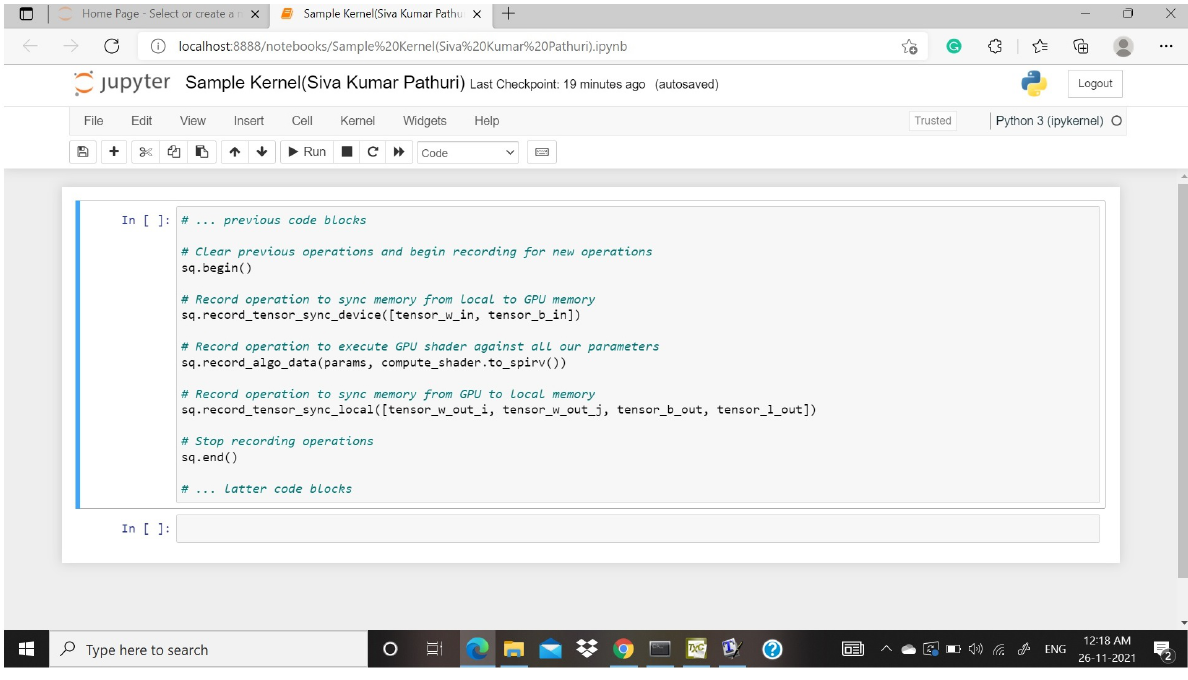
Figure 10. Sample kernel